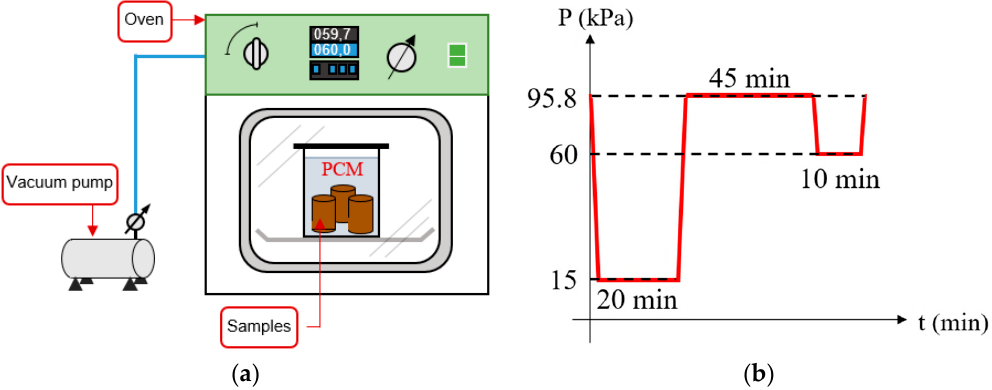
Figure 3. Schematics of ( a ) wood impregnation process in a vacuum oven, and ( b ) stages of the modified Bethel process. Table 2. Mass loss of impregnated wood samples after 6 h at 35 ◦